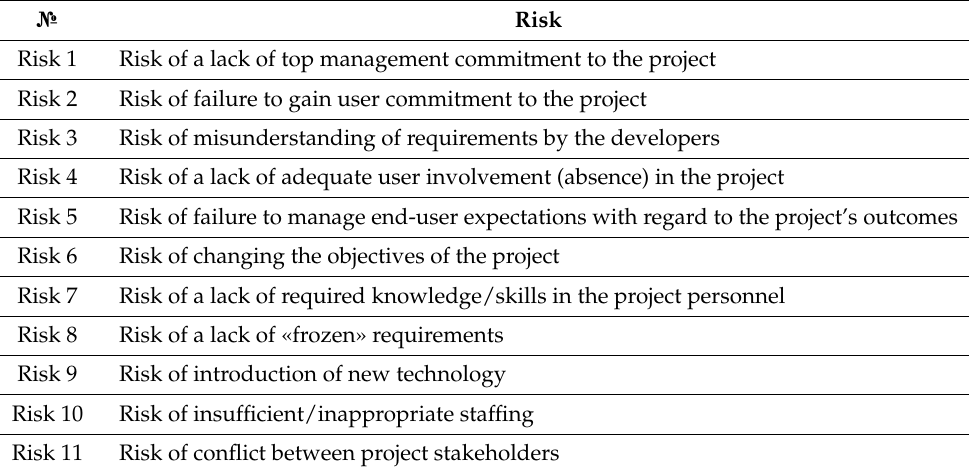
Table 9. List of current IT projects’ risks according to Stevens K. J. и Fowell S. studies’ results.